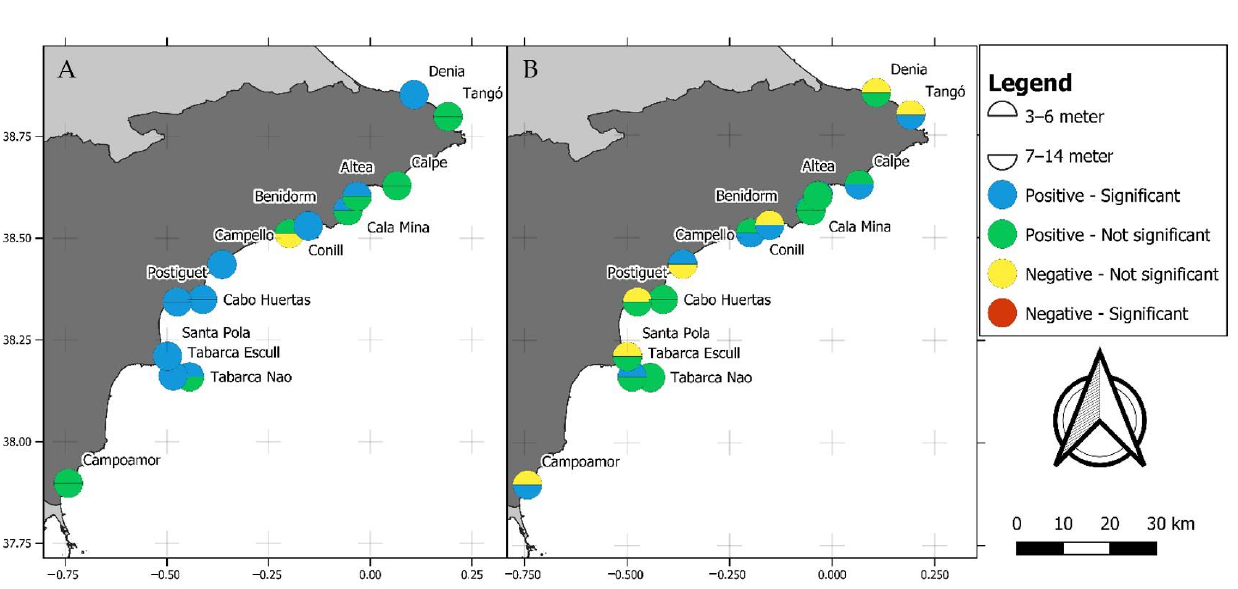
Figure 4. Trends in ( A ) shoot density and ( B ) P. oceanica cover for different monitoring stations representing their global trend (positive or negative) and linear regression results.